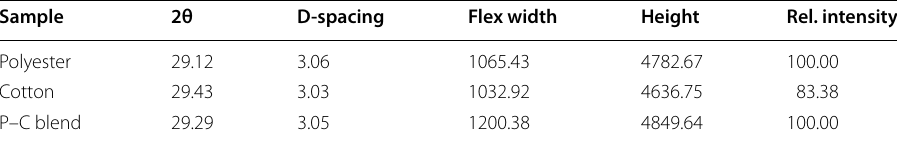
Table 2 XRD analysis of Cu loaded polyester, cotton and P–C blend fabric Sample